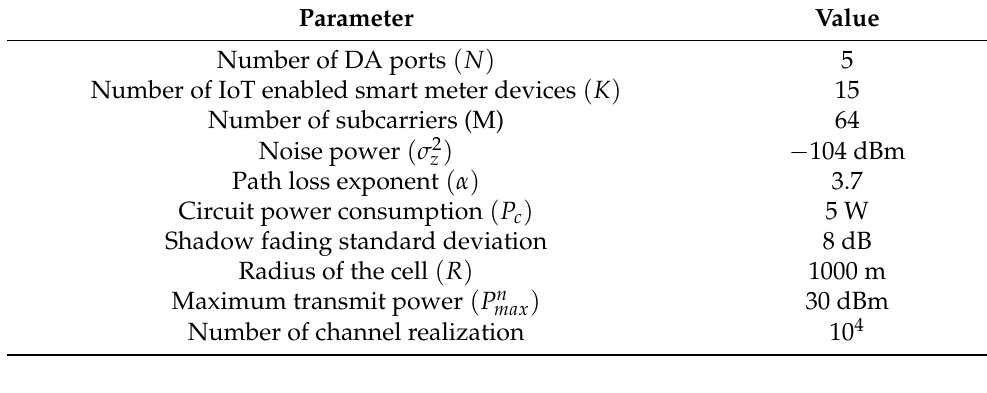
Algorithm 1: Optimal transmit power for